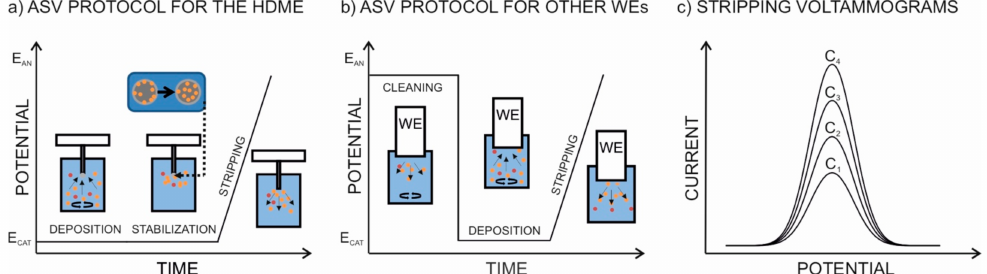
Figure 2. Schematic illustration of the ASV protocol performed with ( a ) the HMDE and ( b ) solid electrodes. ( c ) Expected stripping voltammogram at increasing concentration of one metal ion (C 1 < C 2 < C 3 < C 4 ). E CAT : Cathodic potential. E AN : Anodic potential. WE: Working electrode. Yellow particles: Target metal ions. Red particles: Other metal ions. Grey particles: Mercury